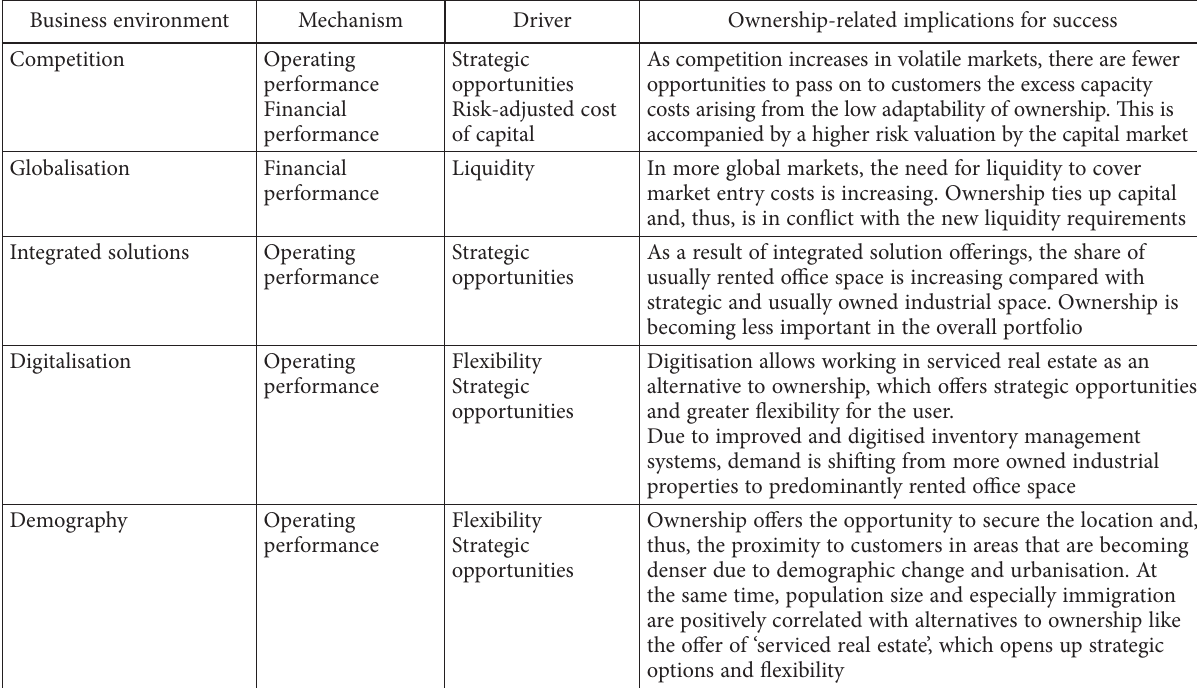
Table 1. Interrelationship between structural change and the changing role of